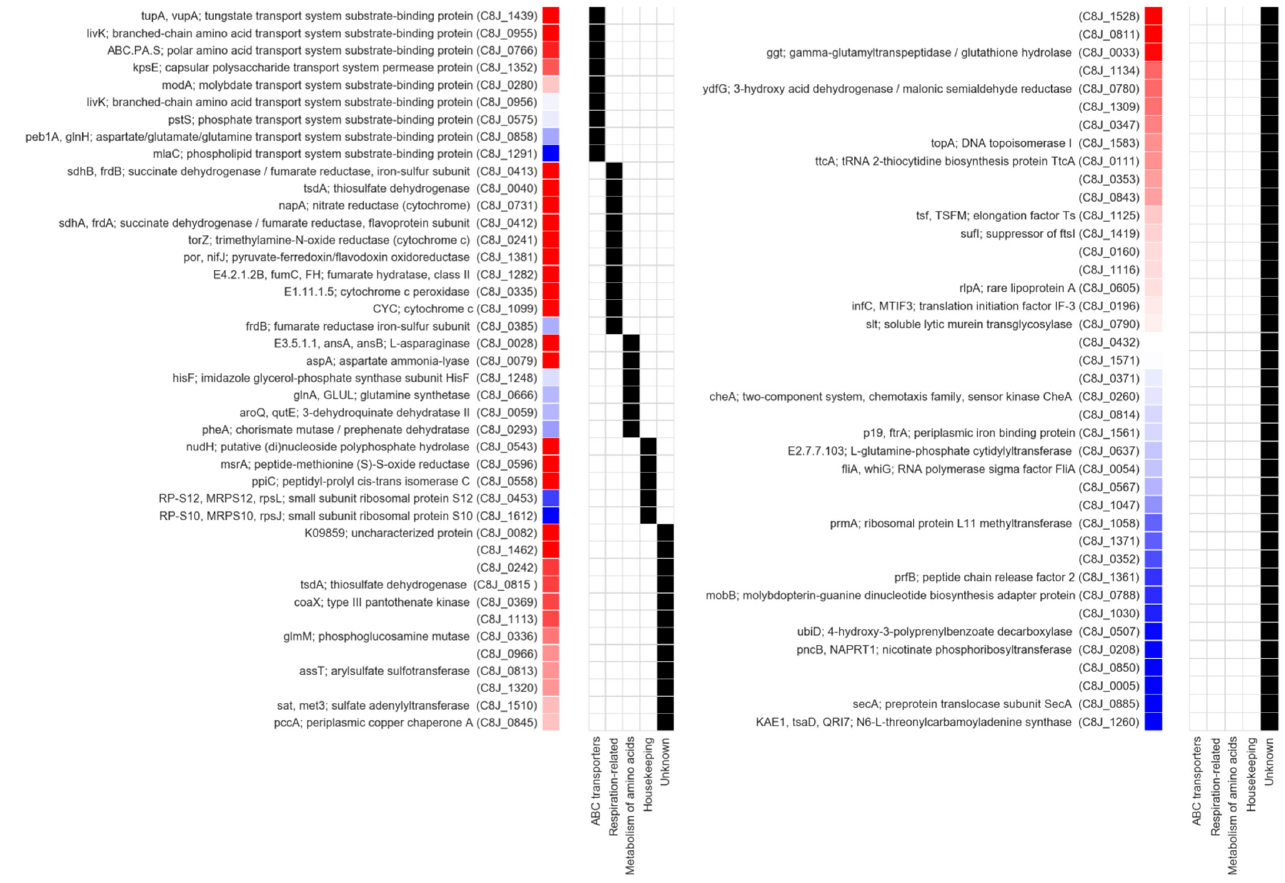
Figure 12. Functional annotation of 82 proteins whose ratio in the strain lacking CjDsbA1 and C8J_1298 to wild-type was 0.55 or less. For clarity, the proteins are listed in two panels. In each, the red to blue scale indicates the significance of the observed depletion (from smallest to largest, respectively), whereas the black boxes denote the functional class according to the KEGG database (the “unknown” class corresponds to the cases in which a given protein had no functional annotation in KEGG).